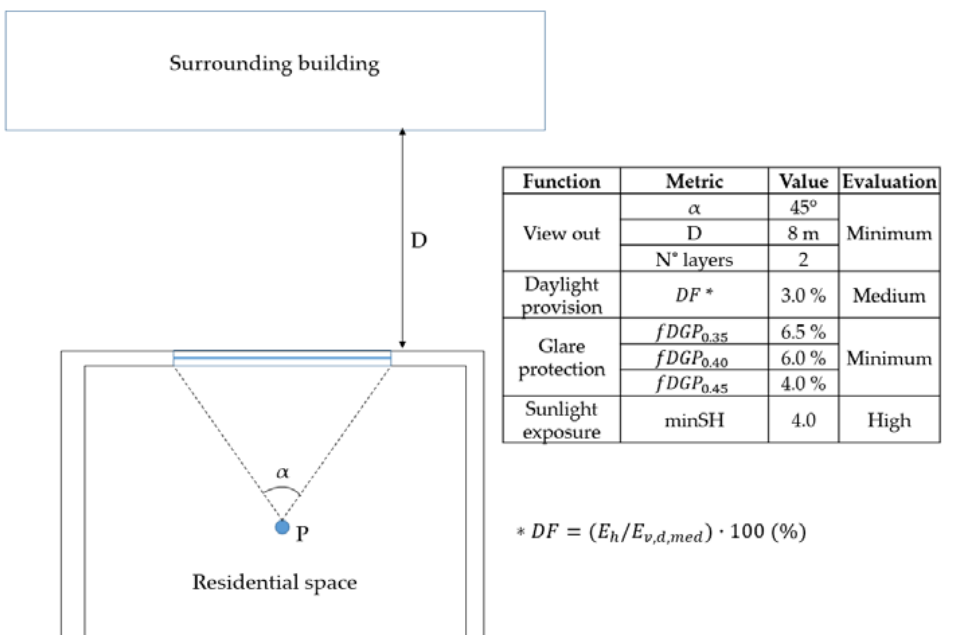
Figure 5. Example of daylight ( DF P ), glare ( fDGP ), and view out ( α , D, and N ◦ layers) assessment for a generic point P where the delightful daylight experience is described by the interviewee. α = horizontal sight angle ( ◦ ), D = distance between buildings (m), E h = Horizontal illuminance (lux), E v , d , med = median external global illuminance (lux), DF = Daylight factor (%), fDGP t = Percentage of occupied hours with DGP above a threshold t (%), and minSH = minimum number of sun hours per day between 1 February and 21